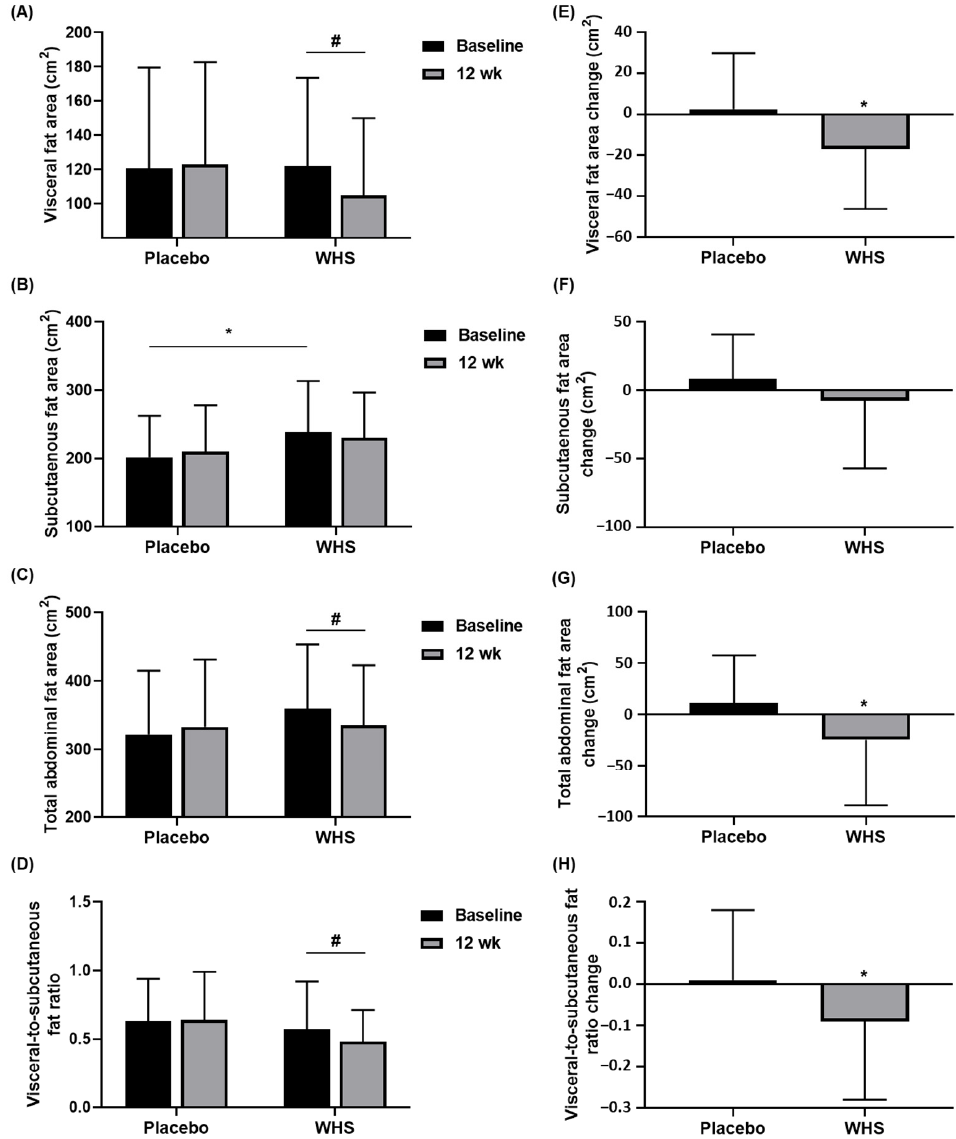
Figure 6. Changes in body fat areas. ( A ) Visceral fat area, ( B ) subcutaneous fat area, ( C ) total abdominal fat area, and ( D ) visceral-to-subcutaneous fat ratio were measured in placebo- and WHS- treated groups at baseline and 12 weeks. ( E – H ) Changes in these parameters between Weeks 0 and 12. Values are present as mean ± SD; # p < 0.05 derived from paired t -test within groups (Weeks 0 vs. 12), and * p < 0.05 derived from a two-sample t -test or Wilcoxon rank-sum test between groups (Placebo ( n = 45) vs. WHS ( n =